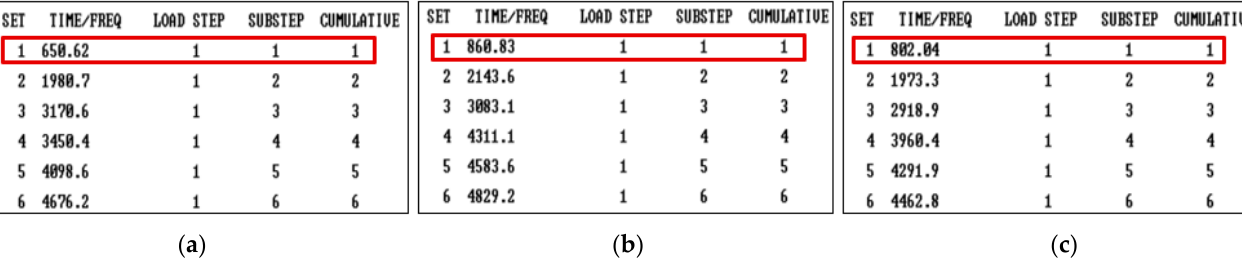
Figure 9. The natural frequency values: ( a ) traditional mirror; ( b ) single-layer truss mirror; ( c ) dou- ble-layer truss mirror.